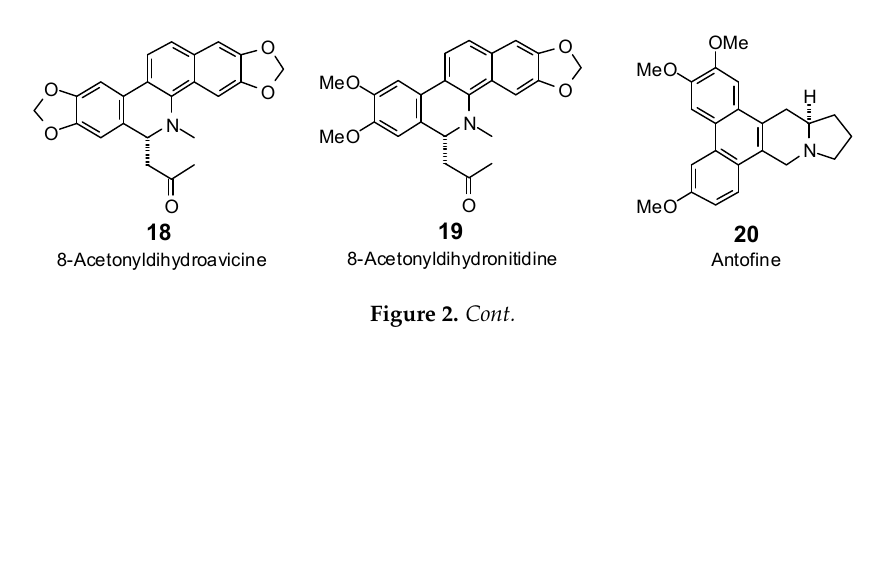
Figure 1. Indole alkaloids examined in this work.